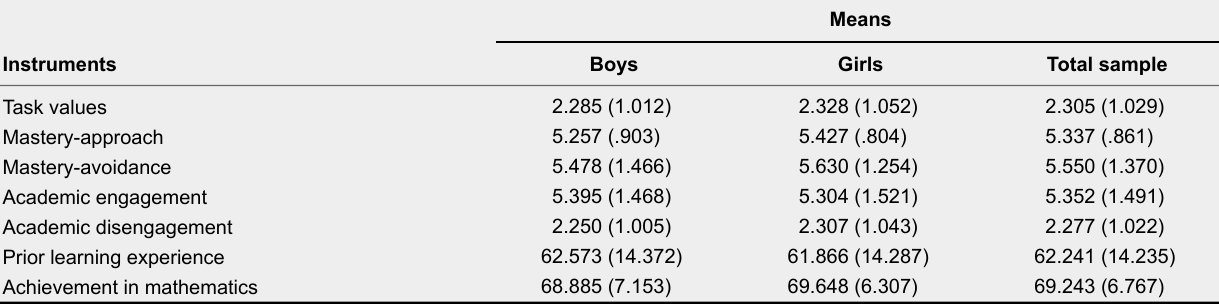
Descriptive Statistics of Means and Standard